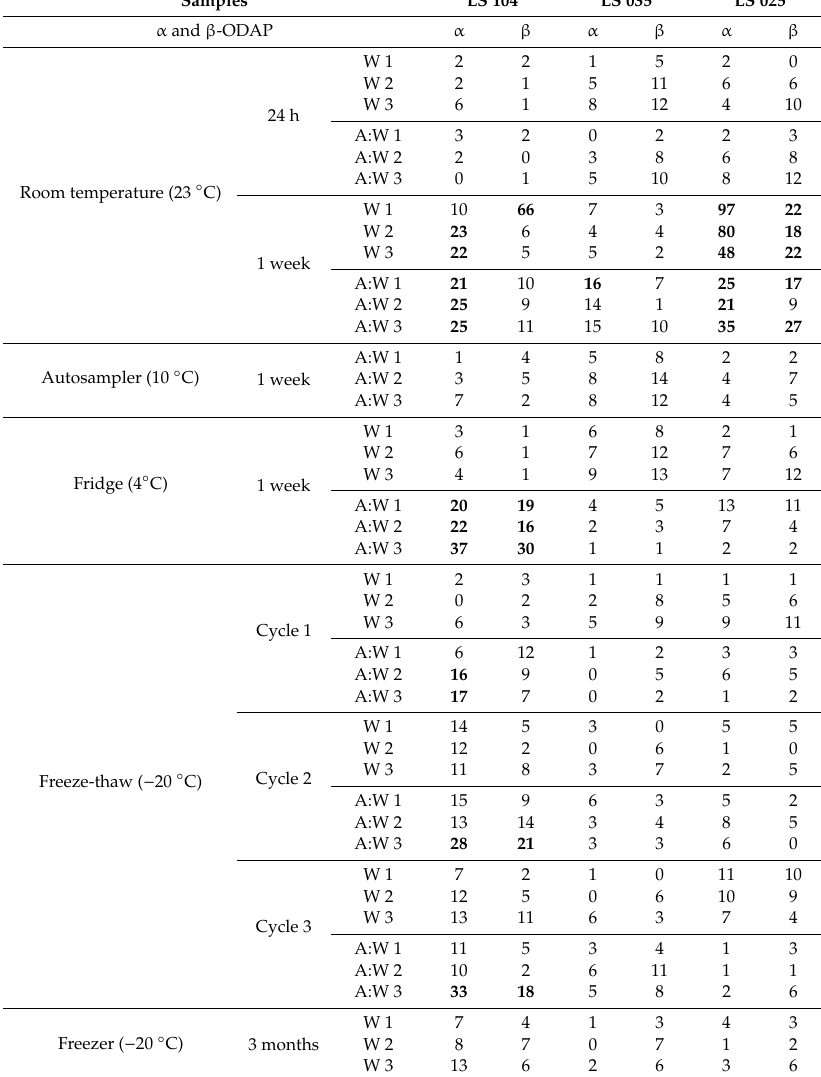
Table 6. β -ODAP stability determined as accuracy and expressed as % for sample extracts before dilution (water extracts, W) and after dilution with acetonitrile:water (40:60) (A:W). Values in bold: accuracy >